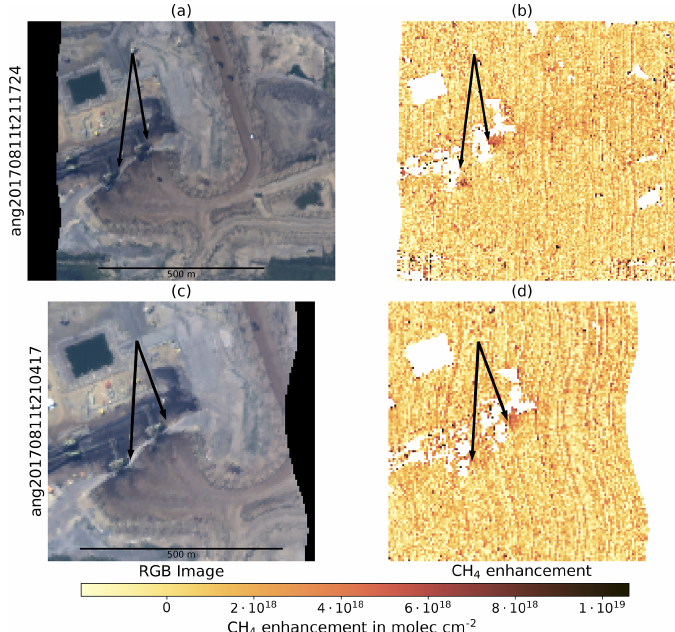
Figure C3. Similar to Fig. C1 but for two overpasses over cold vents at a bitumen extraction site. The plumes are only faint, especially for the second overpass (d) . In the results, a small striping effect is still visible. The destriping reduces the effect but is not able to totally eliminate